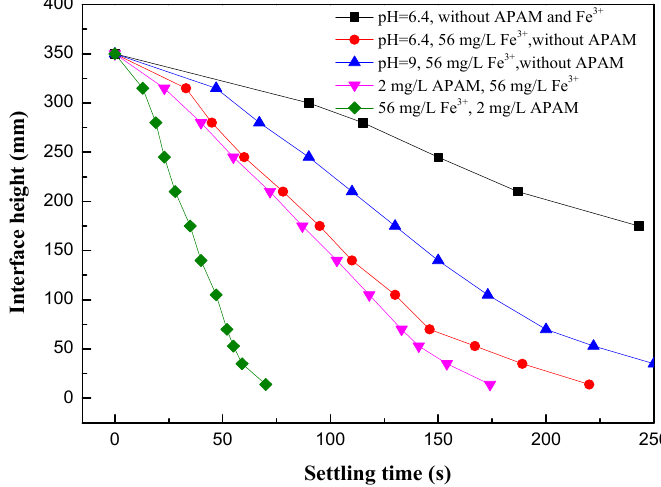
Figure 4. Effect of Fe 3+ and adding order of reagents on the sedimentation (regulating time: 5 min).